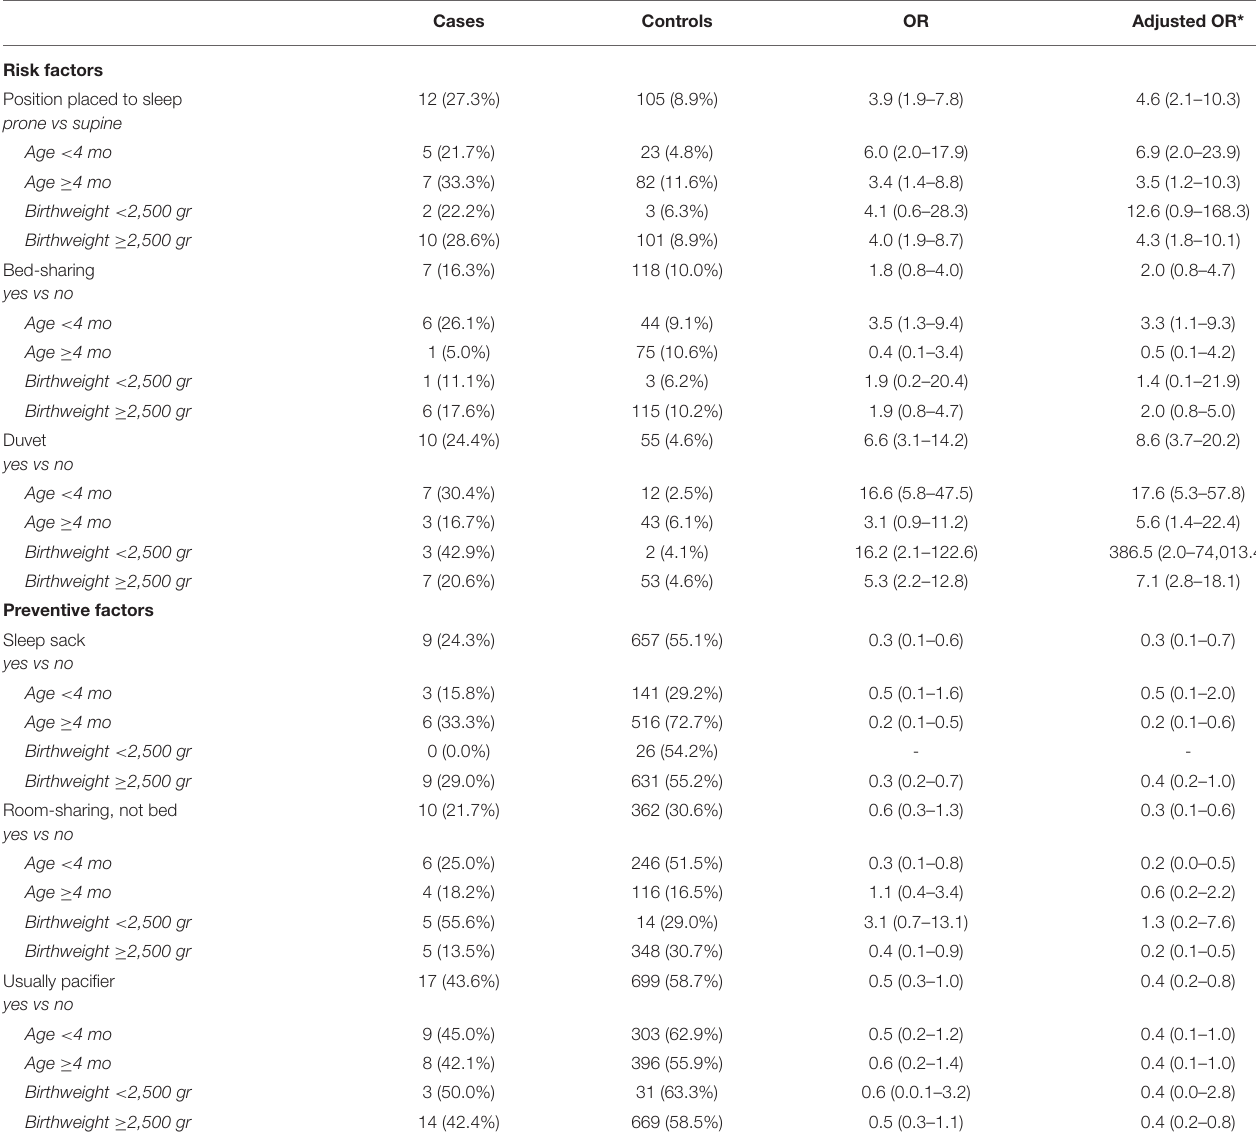
TABLE 3 | Prevalence in cases and controls of known risk and preventive factors for SUDI, stratified for age and birthweight, and the Odds Ratio (OR), both crude and adjusted in these